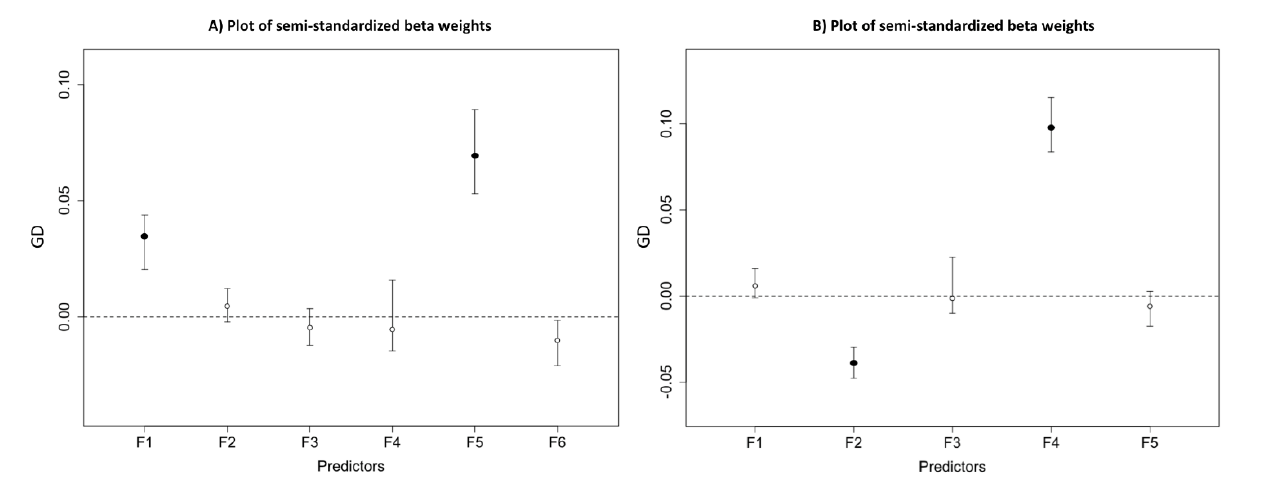
Figure A1.6 Commonality analysis beta weights with filled circles indicating significant beta weights for the A) archaeological surface with 95% bootstrap confidence intervals. (F1=Language family residuals, F2=Fish trap residuals, F3=Midden residuals, F4=Ice and snow residuals, F5=Waterway residuals, F6=Ruggedness residuals) and B) the modern surface with 95% bootstrap confidence intervals. (F1 = Modern settlement residuals, F2 = Forestry residuals, F3 = Ice and snow residuals, F4 = Waterway residuals, F5 = Ruggedness